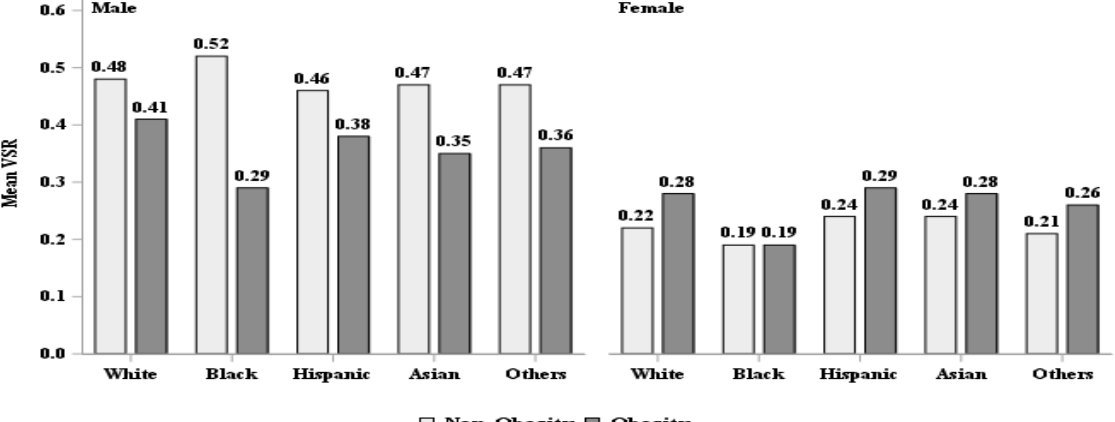
Figure 2. VFA (cm 2 ) and VSR description by body mass index classified obesity. VFA = visceral fat area, VSR = visceral to subcutaneous adipose area ratio.